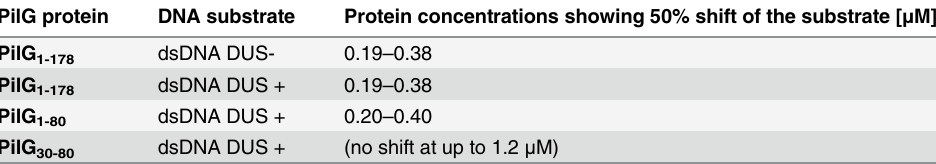
Table 4. DNA binding abilities of PilG partial proteins in EMSA. The protein concentration required to achieve a shift with 50% of the DNA substrate is indicated and can be used to estimate the dissociation con- stant, K d , of the protein-DNA complex